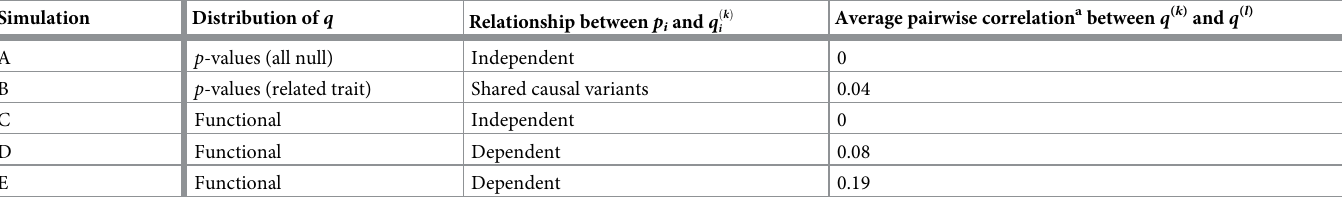
Table 1. Summary of simulation